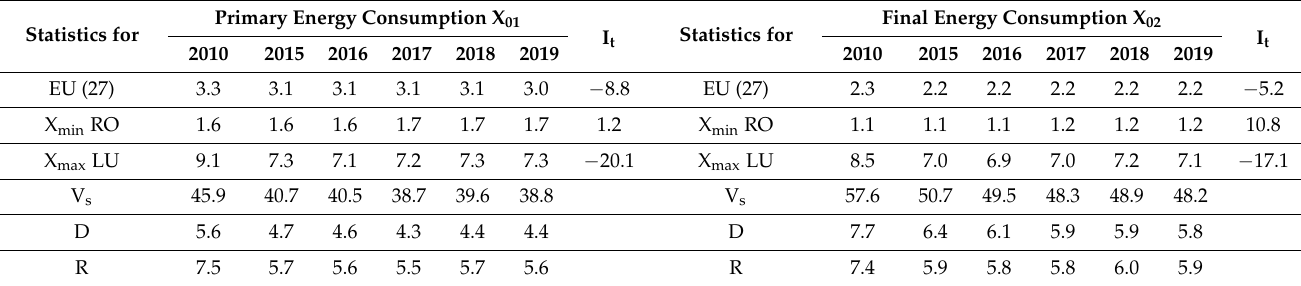
Table 2. Primary and final energy consumption in EU (27) countries in 2010–2019—statistics.